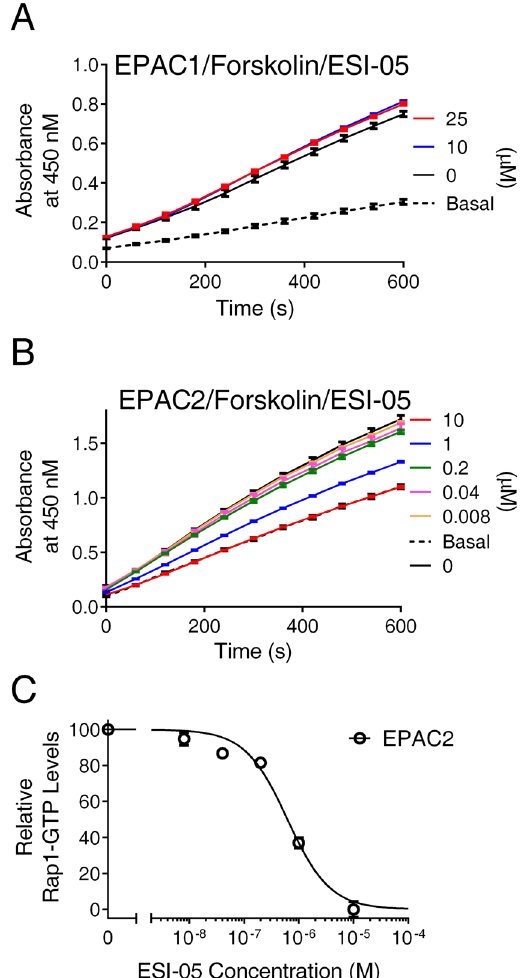
Figure 6. Dose-dependent inhibition of forskolin-induced cellular EPAC1 and EPAC2 activation by ESI-05. ( A ) Time course of EPAC1-mediated Rap1 activation induced by 1 µ M forskolin in the presence of various concentrations of ESI-05. ( B ) Time course of EPAC2-mediated Rap1 activation induced by 1 µ M forskolin in the presence of various concentrations of ESI-05. ( C ) Relative Rap1-GTP levels induced by 1 µ M forskolin as a function of ESI-05 concentration in HEK293 cells overexpressing EPAC2. Data are presented as Means ± SD, n =